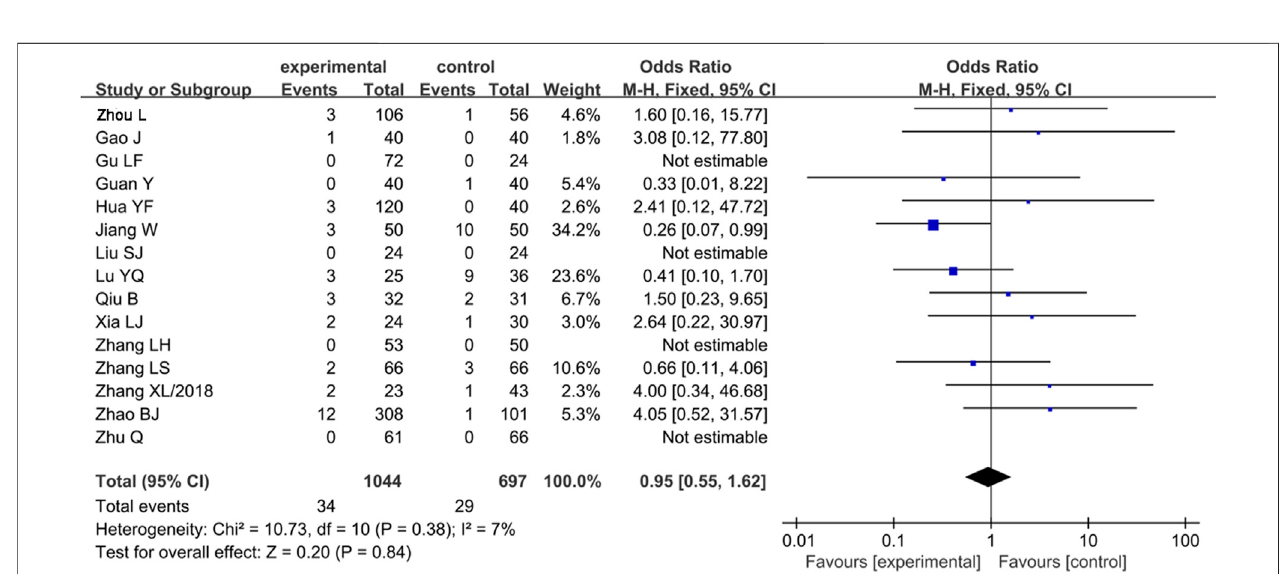
Frontiers in Pharmacology |